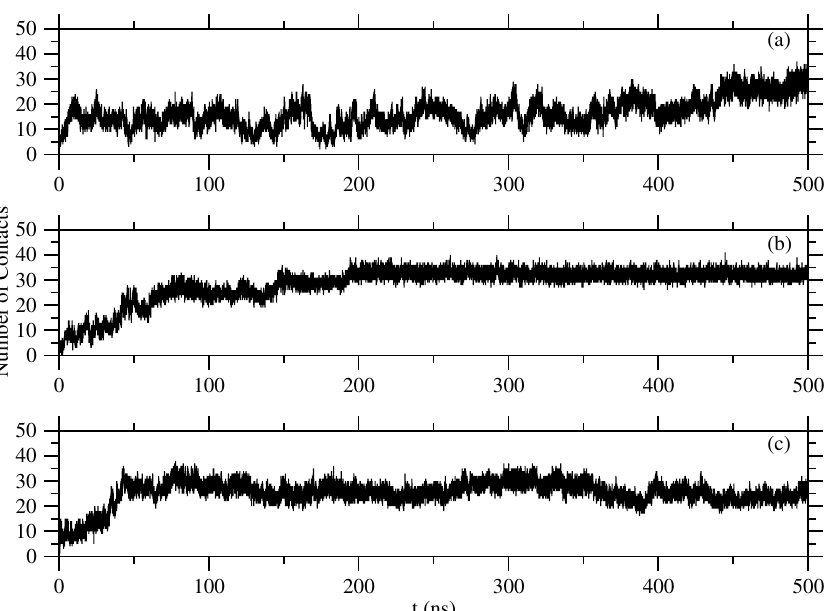
Figure 8. Number of close contacts between C α atoms of ( a ) Phe, ( b ) Tyr, and ( c ) Trp